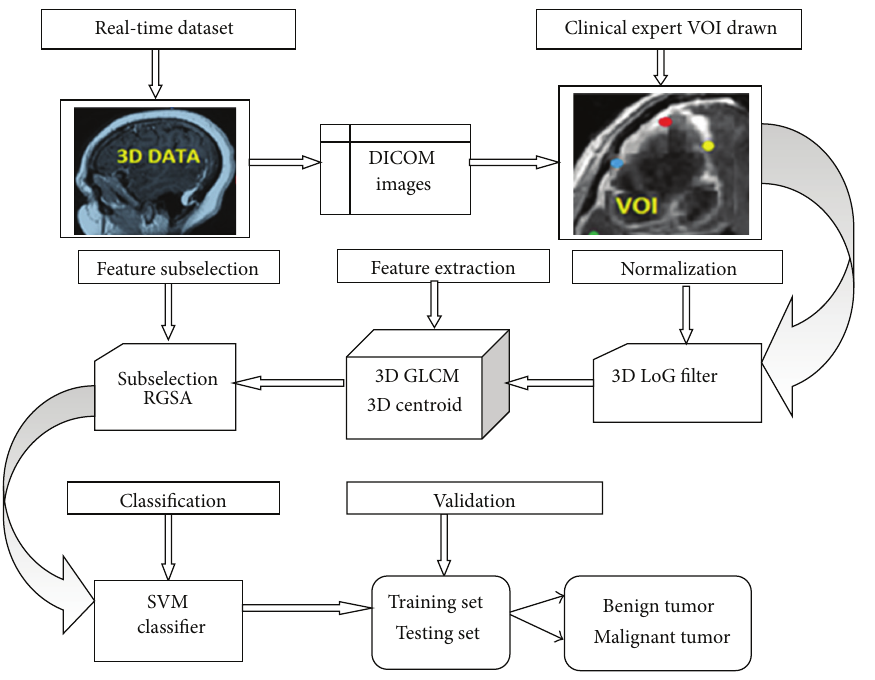
Figure 1: Framework of the proposed CAD classification model.